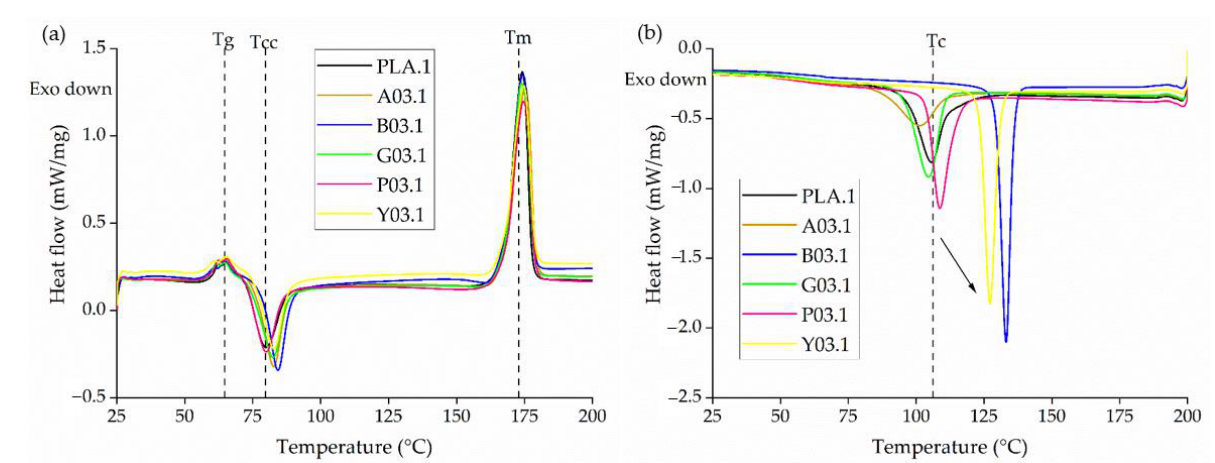
Figure A1. DSC thermograms of PLA and dyed yarns containing 0.3% ( w / w ) of each colorant at an SSD ratio of 1 during ( a ) the heating cycle and ( b ) the cooling cycle.